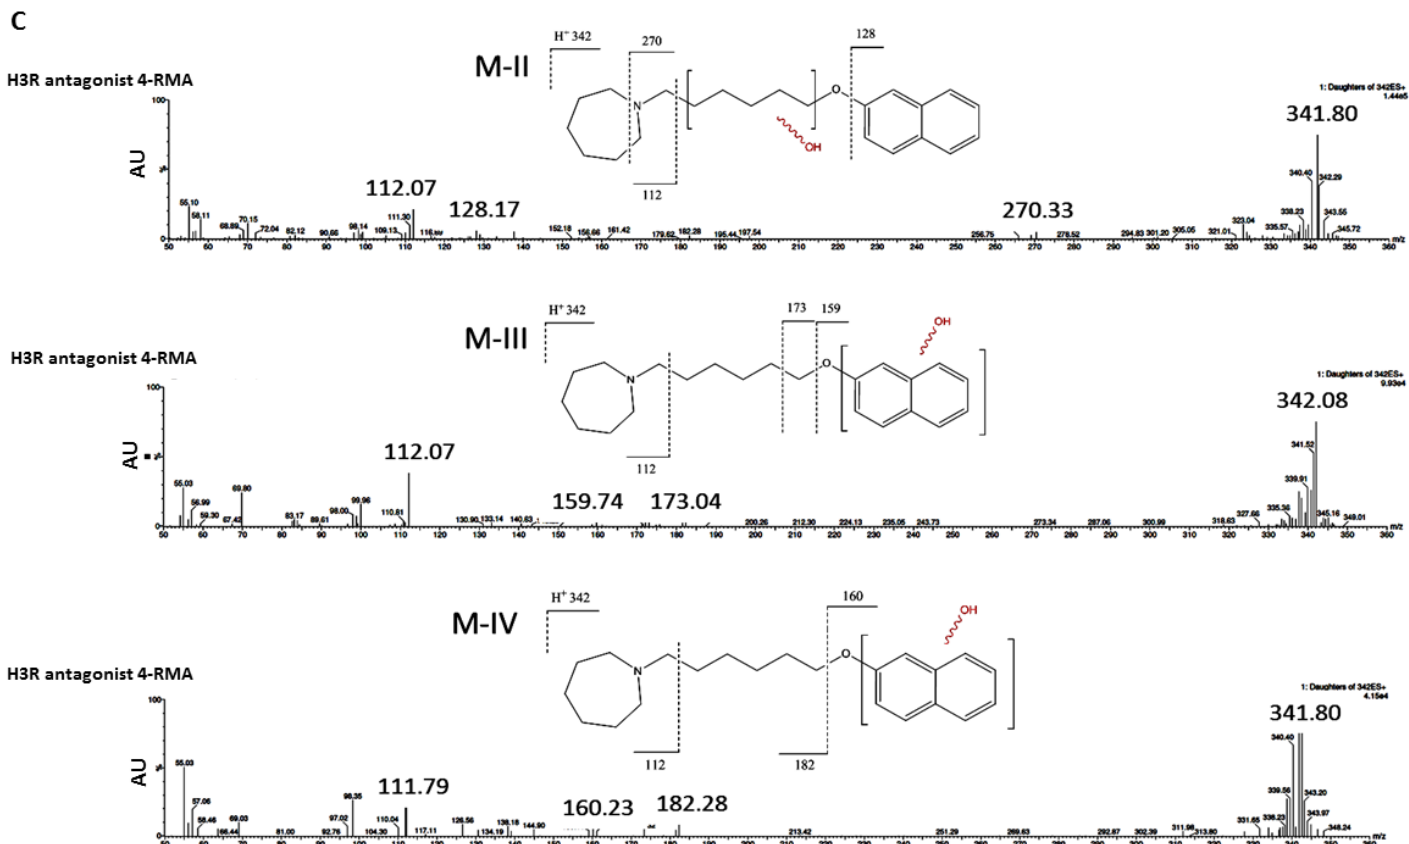
Figure 6. The metabolic profile of H3R antagonist after incubation of H3R antagonist 4 with rat liver microsomes. The UPLC spectrum obtained two hours post incubation of H3R antagonist 6 with rat liver microsomes. ( A ) Around 20% of H3R antagonist 4 was metabolized. ( B ) Main metabolite MI of H3R antagonist 4 with a double-hydroxylation identified as the main metabolic route. ( C ) The mass spectrometry (MS) fragmentation analysis of most probable hydroxylation sites MII–MIV with rat liver microsomes. Abbreviations: UPLC, ultra-performance liquid chromatography.